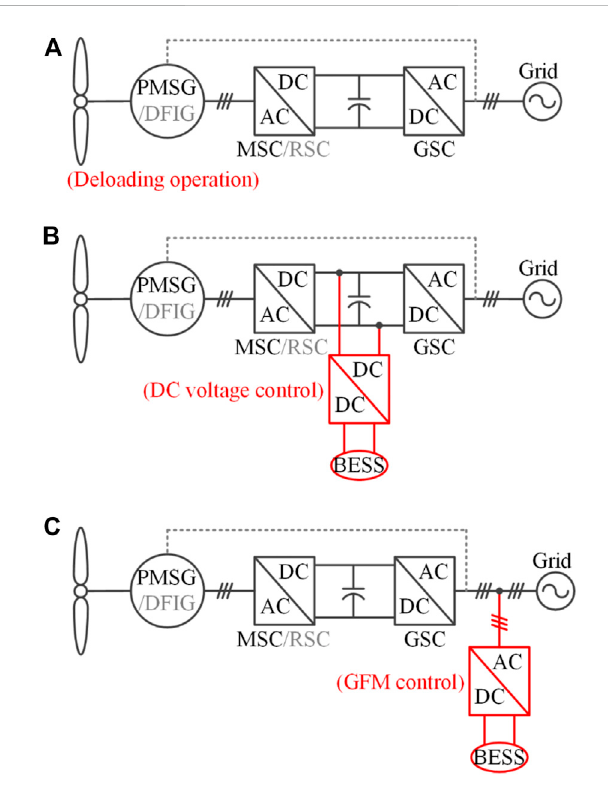
FIGURE 2 Three possible energy reserving schemes for wind generation systems. (A) Deloading operation of the wind turbine (Vidyanandan and Senroy, 2013; Ducar et al., 2017; Krpan and Kuzle, 2020; Kumar et al., 2020; Dong et al., 2021); (B) Adding an energy storage system on the dc-side (Chen et al., 2021); (C) Adding an energy storage system on the ac-side (Kouassi and Francois, 2016; Chen et al., 2021; Zhao et al.,